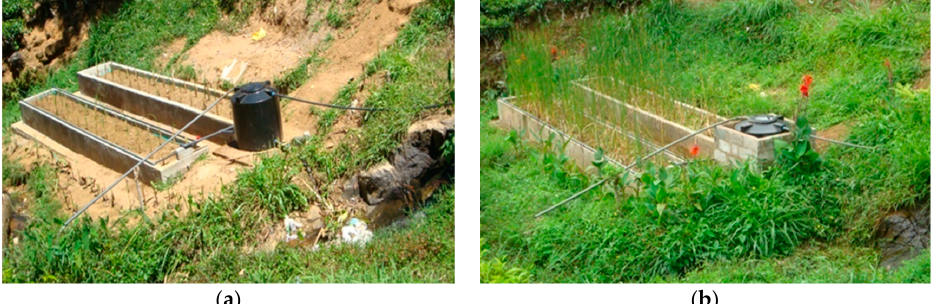
Figure 4. Arrangement of wetland units in the field: ( a ) just after planting; and ( b ) mature wetland units.